Question: Give a one-sentence summary of this figure.
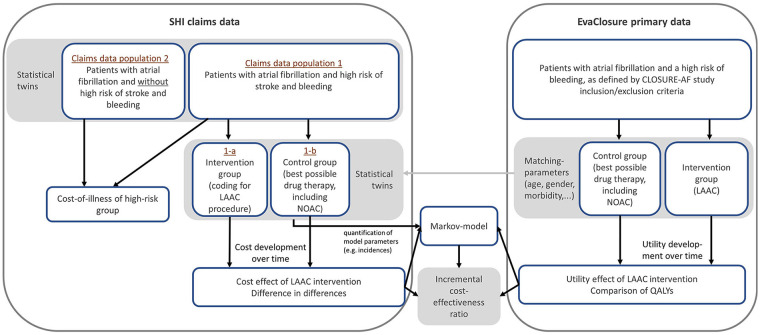
Answer: (N)OACs and approved/studied doses across indications.